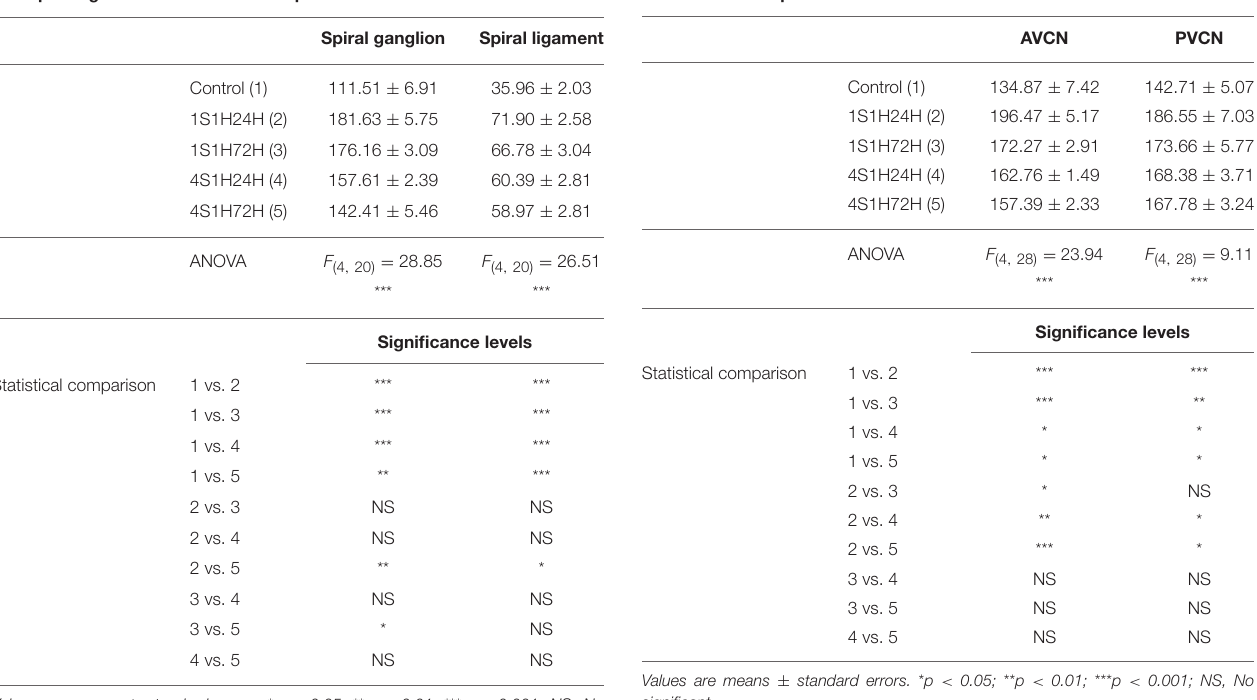
TABLE 7 | Mean gray level of CR immunostaining in the AVCN and PVCN in control and experimental